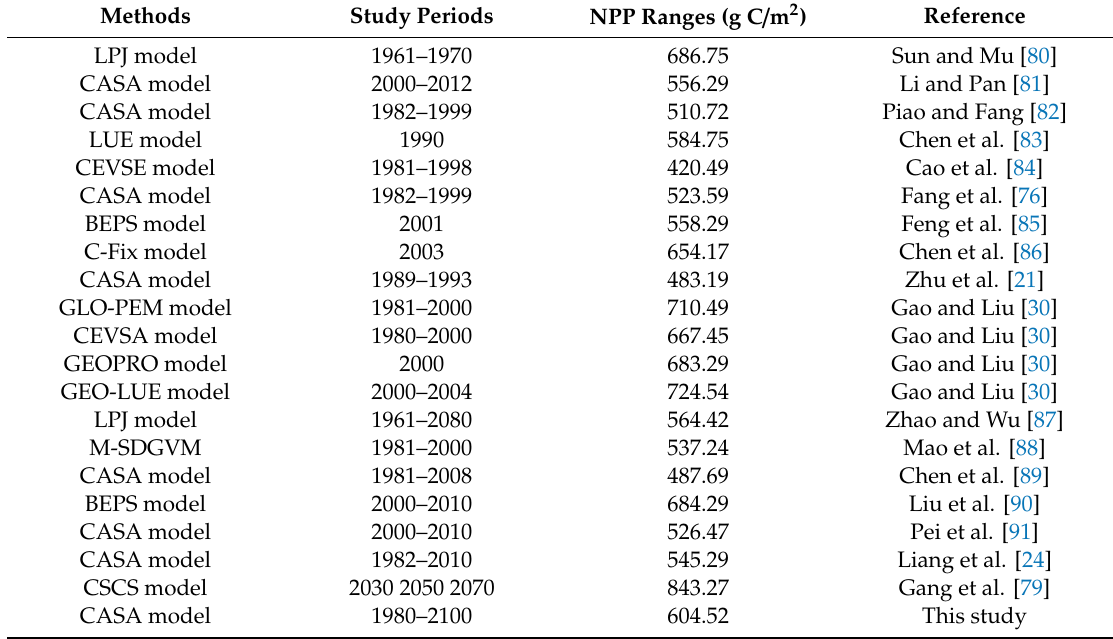
Table 4. Summary of studies of NPP in